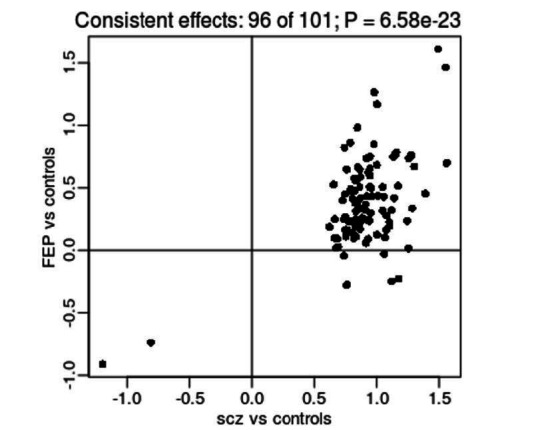
Comparison of effect sizes from an EWAS of diagnosed SZ (x-axis) and FEP (y-axis) for SZ-associated DMPs.Shown is the mean difference (% DNAm) between cases and controls.